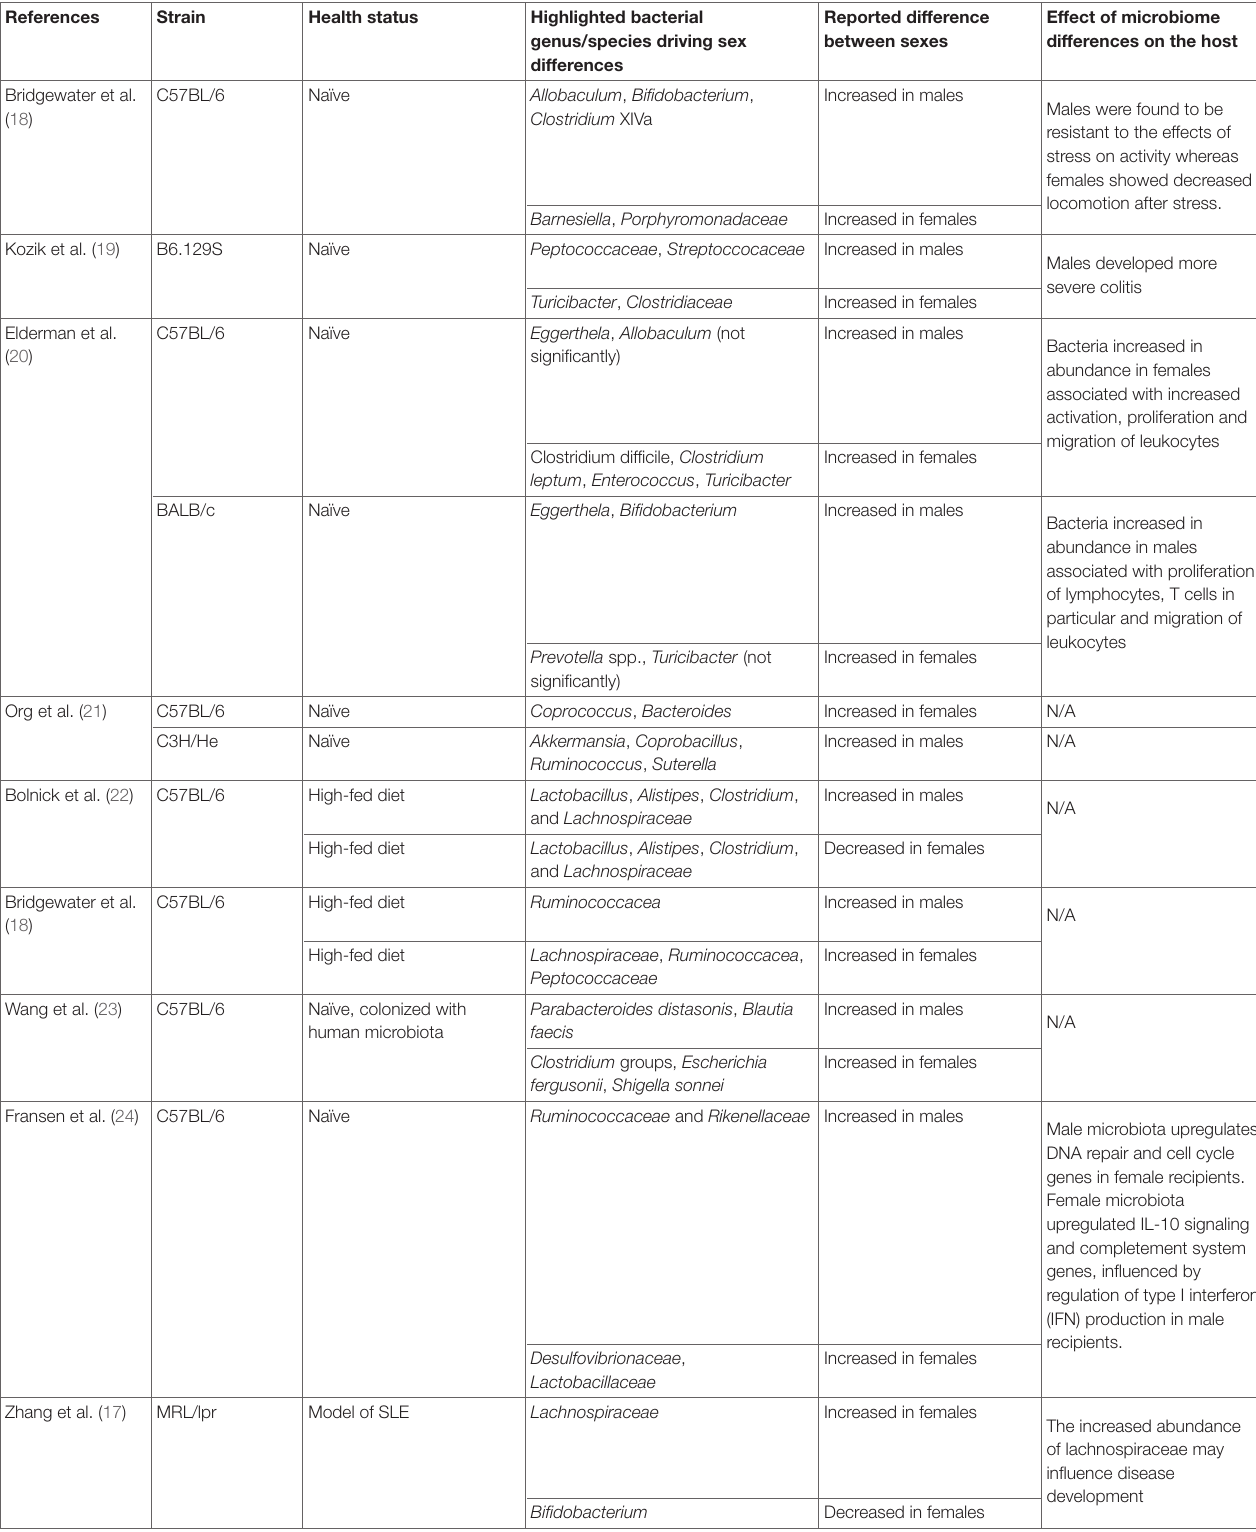
TABLE 1 | Bacterial genus/species driving post-pubescent sex differences in referenced